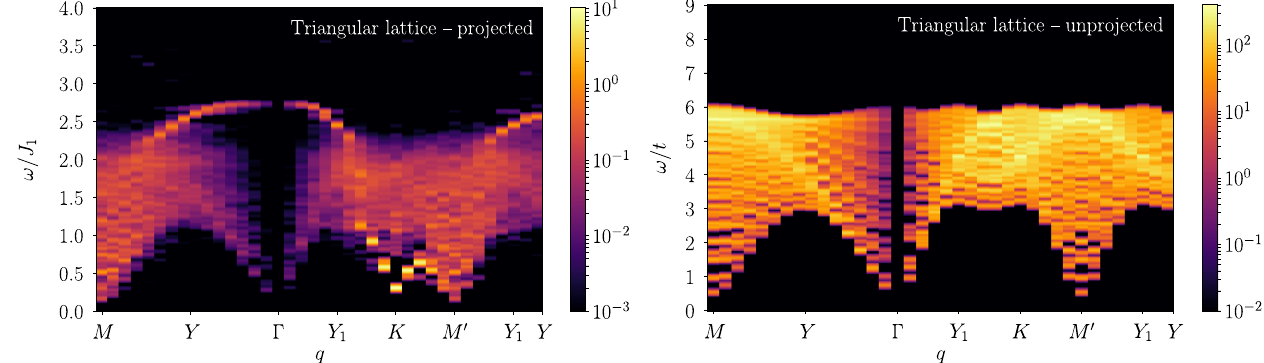
FIG. 8. The dynamical structure factor for the J 1 − J 2 Heisenberg model on the 30 × 30 cluster with J 2 =J 1 ¼ 0 . 125 . The variational results (left) are compared to the ones obtained from the unprojected Abrikosov fermion Hamiltonian H 0 of Eq. (13) with t ¼ 1 and h ¼ 0 (right). The path along the Brillouin zone is shown in Fig. 1. We applied a Gaussian broadening of σ ¼ 0 . 02 J results. Notice that, for the unprojected data, the energy scale is given by the hopping amplitude t of the unprojected Hamiltonian Eq. (13), instead of J 1 . In addition, the broadening has been rescaled in order to account for the larger bandwidth of the spectrum.